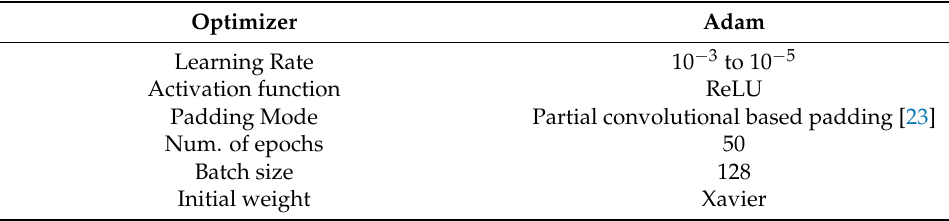
Table 3. Hyper-parameters of the proposed methods.